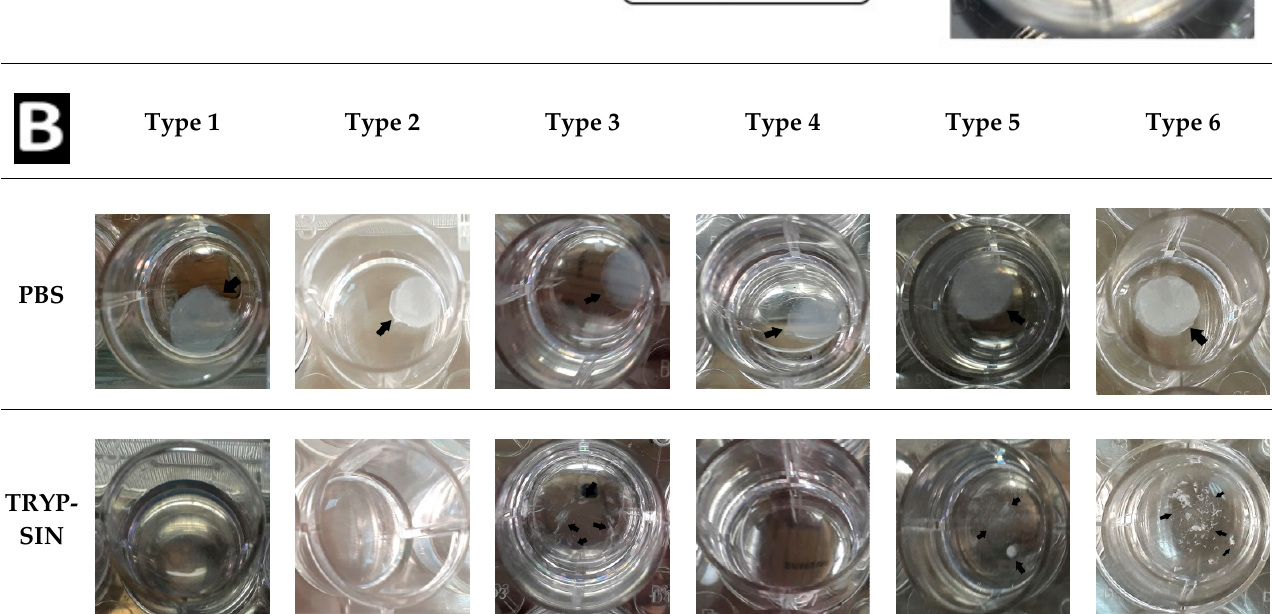
Figure 6. ( A ) Introduction to the experiment. Representative photographs of the scaffolds. The appearance of the scaffolds of all Types before their introduction into the experiment was identical. ( B ) Appearance of scaffold samples after 1008 h of biodegradation in vitro.